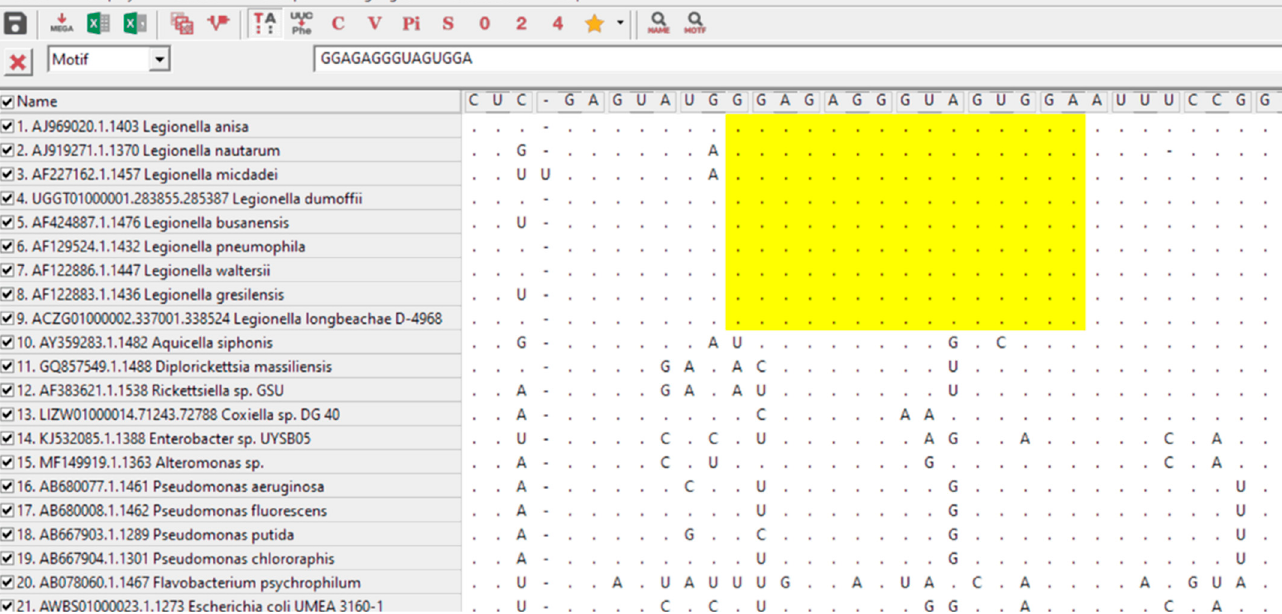
Figure 1. Partial alignment of 16S rRNA sequences for Legionella probe selection using ClustalW from MEGA ‐ X software. Yellow shadow shows the selected region that matched all Legionella sequences but did not match the nontarget sequences. The sequence shown corresponds with LEG22 complementary reverse sequence.